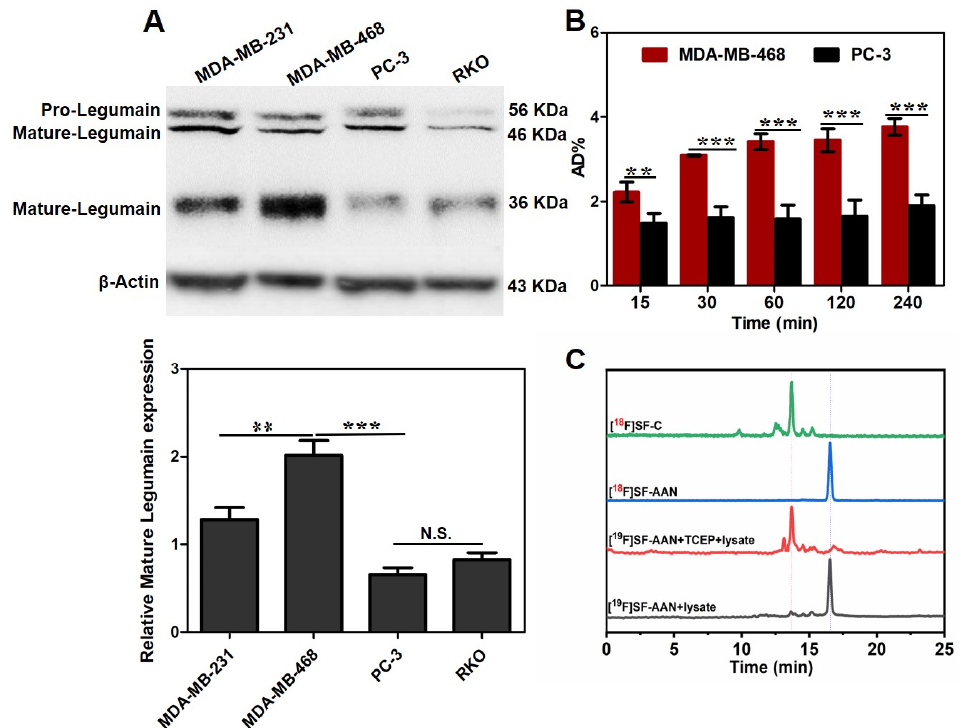
Figure 3. ( A ) Western blotting analysis of legumain expression level in different cell lines. ( B ) Cellular uptake of [ 18 F] SF-AAN in MDA-MB-468 and PC-3 cells at different time points. Error bar represents standard deviation ( n = 3), N.S. denotes no significant difference, ** denotes p < 0.01; *** denotes p < 0.001. ( C ) HPLC analysis of [ 19 F] SF-AAN (50 μ M) in the MDA-MB-468 cell lysates (black) and TCEP (red) at 37 °C for 10 h and [ 18 F] SF-AAN (22.2 MBq) (blue) incubated with MDA-MB-468 cells (green) at 37 °C for 1 h.